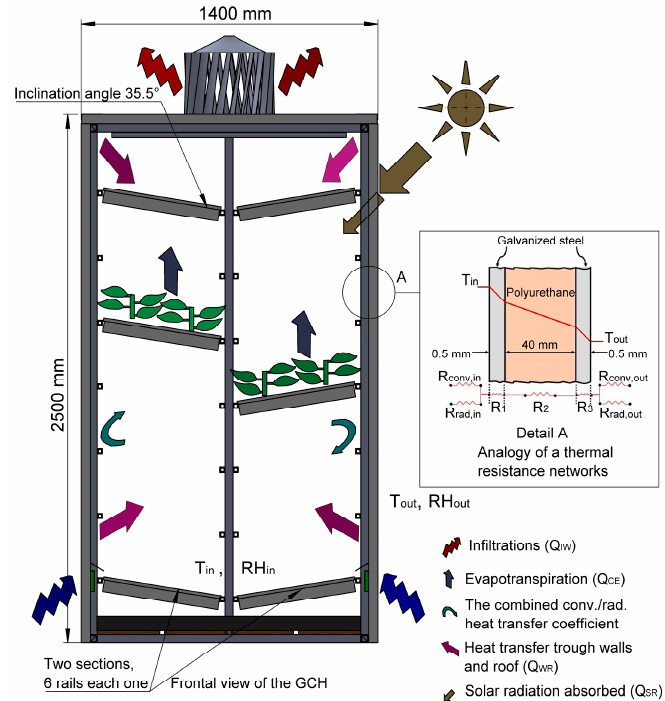
Figure 2. Mass and heat interactions between inside and outside variables of the growth chamber.